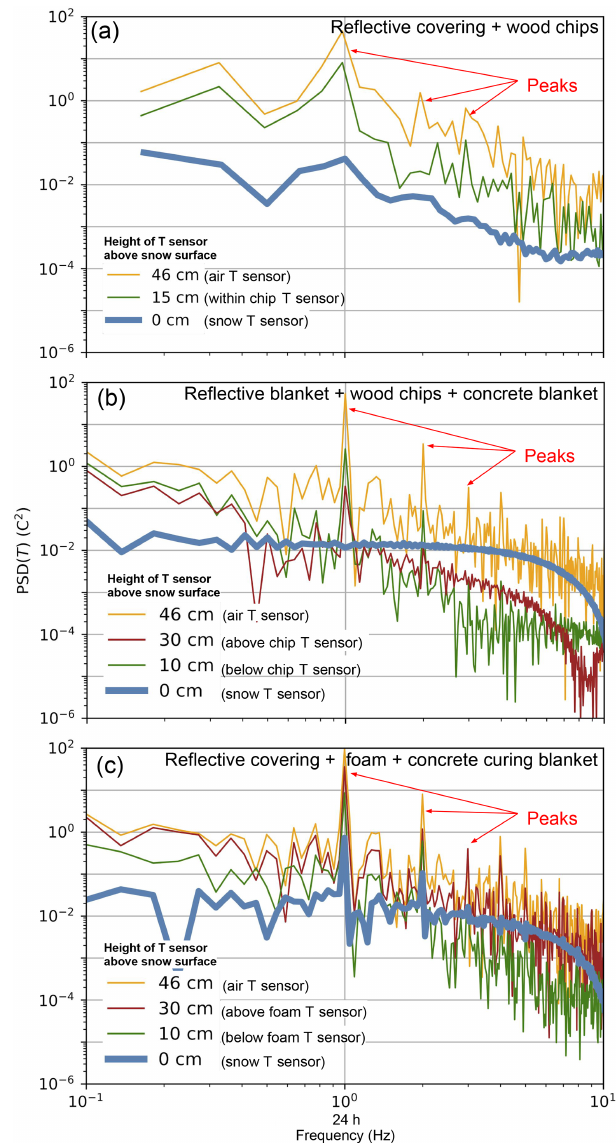
Figure 8. Power spectral density of temperature records from three different cover experiments (Fig. 4b, e, and f). PSD normalizes fre- quency to 24h = 10 0 and displays the magnitude of each tempera- ture oscillation frequency for each sensor per experiment (depth in centimeters measured above sensor at the snow – 0cm). (a) Experi- ment with woodchips and reflective cover (Fig. 4b). (b) Experiment with a concrete curing blanket, woodchips, and a reflective cover (Fig. 4e). (c) Experiment with concrete curing blanket, open-cell foam, and a reflective cover (Fig. 4f). The lack of detectable signal (flat blue line) at snow level (0cm) in (b) demonstrates that three- layer configuration with woodchips best damps the diurnal temper- ature signal. Colors correspond to colors from Fig.